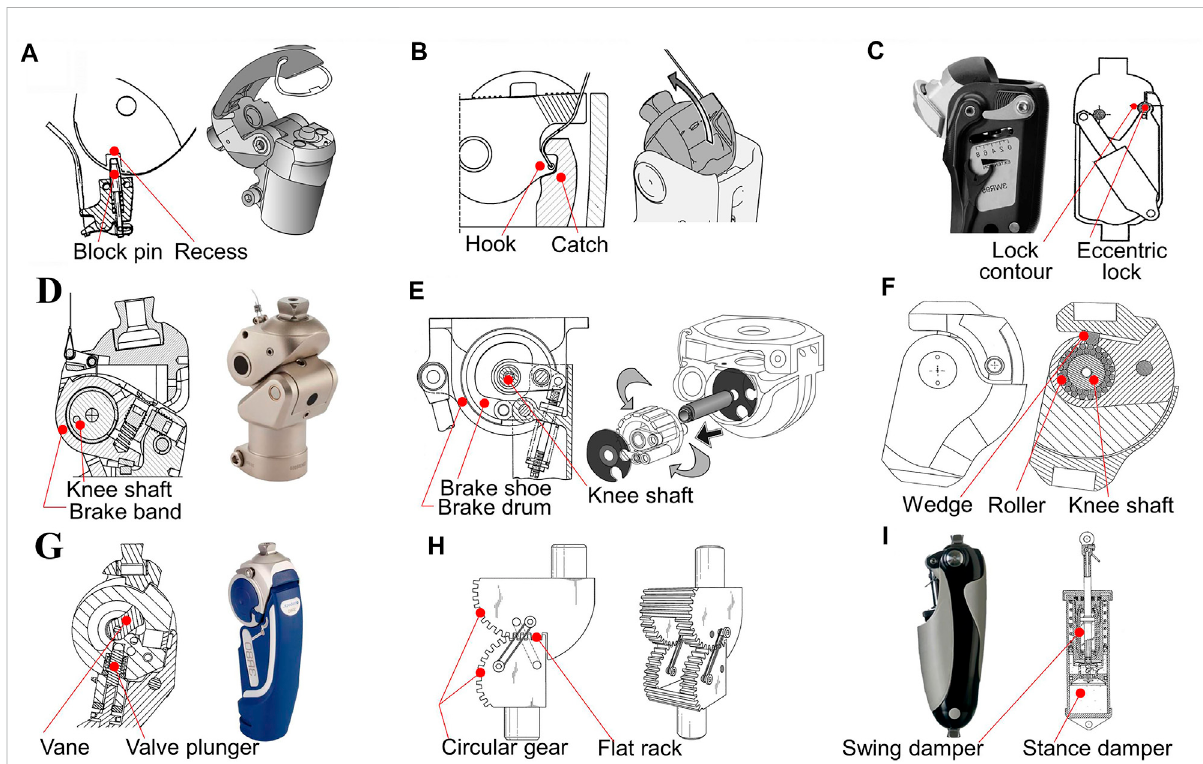
FIGURE 5 Monocentricknees for stancestability. (A) Manually locking knee with the block pinand recess (Blatchford ® Compact SAKL, Boiten etal., 2015), reproduced with permission from copyright 2017 by Blatchford ® . (B) Manually locking knee with the hook and catch (Ottobock ® Prosedo 3R31, Haupt, 1987), reproduced with permission from copyright 1987 by Ottobock ® . (C) Manually locking knee with the eccentric mechanism (Ottobock ® Aqua3WR95,BröcklandDietl,2015),reproducedwithpermissionfromcopyright2015byOttobock ® . (D) Weight-activatedkneewiththebrake shaft and band (Ossur ® Balance OFM2, Karlsson et al., 2015), reproduced with permission from copyright 2017 by Ossur ® . (E) Weight-activated knee with the brake drum (Blatchford ® ESK + , (Blatchford and Tucker, 1980), reproduced with permission from copyright 1980 by Blatchford ® . (F) Weight- activated knee with the frictional bushing (Wagner and Krukenberg, 2000), reproduced with permission from copyright 2000 by Ottobock ® . (G) Weight-activated knee with the hyraulic brake (Ottobock ® 3R80, Wagner and Krukenberg, 1998), reproduced with permission from copyright 1998 by Ottobock ® . (H) Weight-activated knee with the gear meshing mechanism (Ramakrishnan and Reed, 2020), reproduced with permission from copyright 2020 by South Florida University. (I) Hyperextension-controlled knee (Ossur ® Mauch, Mauch, 1968), reproduced with permission from copyright 1968 by Ossur ®